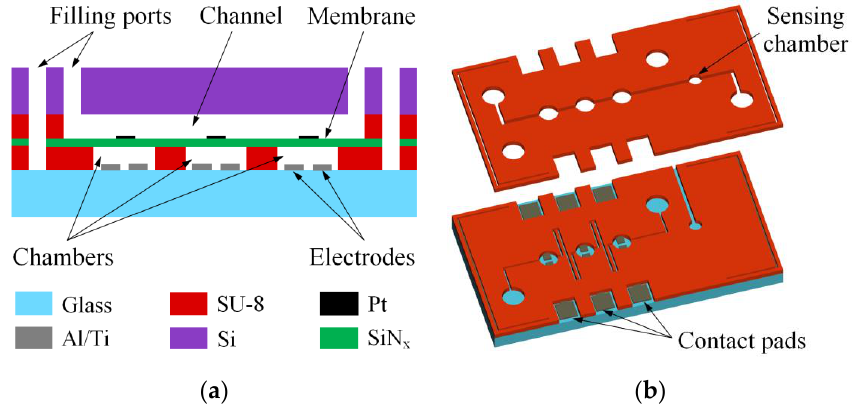
Figure 1. A schematic illustration of the micropump: ( a ) a cross-section; ( b ) a three-dimensional view of the glass substrate with the electrodes and the channels for liquids.